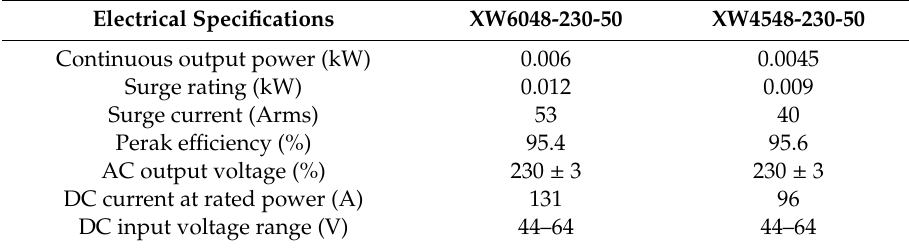
Table 2. Hybrid inverter / charger-230 V / 50 Hz